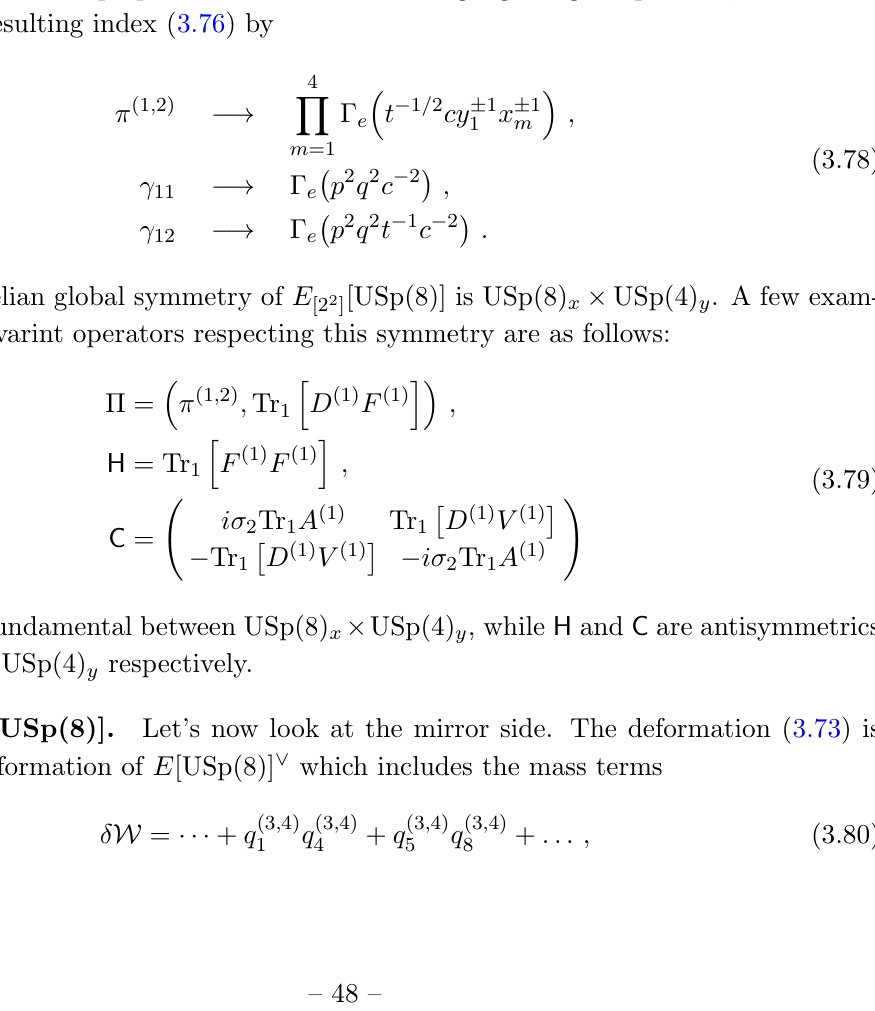
Figure 21 . The quiver diagram representation of E sizes on top of the diagonal line denote the singlets (cid:13) 11 and (cid:13) 12 , which (cid:13)ip Tr 1 h i Tr 1 A (1) D (1) D (1) [1 2]